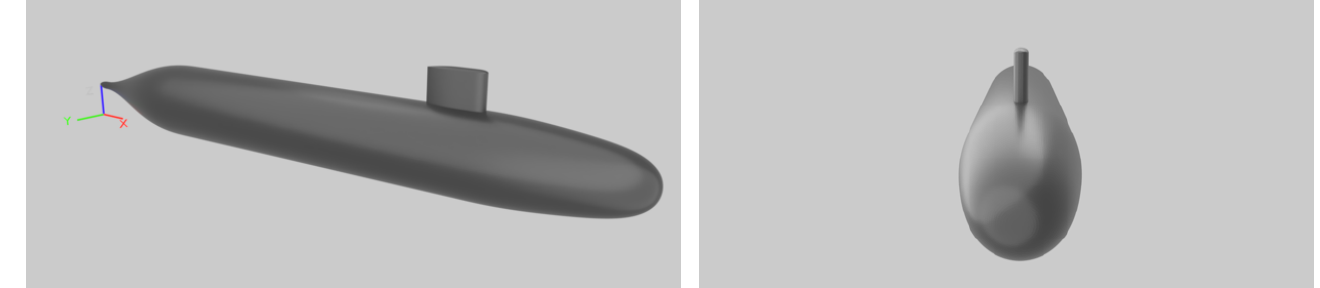
Figure 2. 3D CAD model of DARPA SUB-OFF submarine used in the present study. For the Type 209/1300 submarine, a complete CAD model was generated by com- bining original blueprints provided by shipowner and measurements taken during a scheduled dry-dock maintenance. However, appendages with dimensions smaller than 10 cm such as: hydroplanes, passive sonars, antennas, and collision bumpers, were not included in the CAD version used in the current work. This simplified CAD version, shown in Figure 3, was used in the numerical simulations to decrease the required computational time per simulation, where neither propeller geometry nor its hull interaction is included.